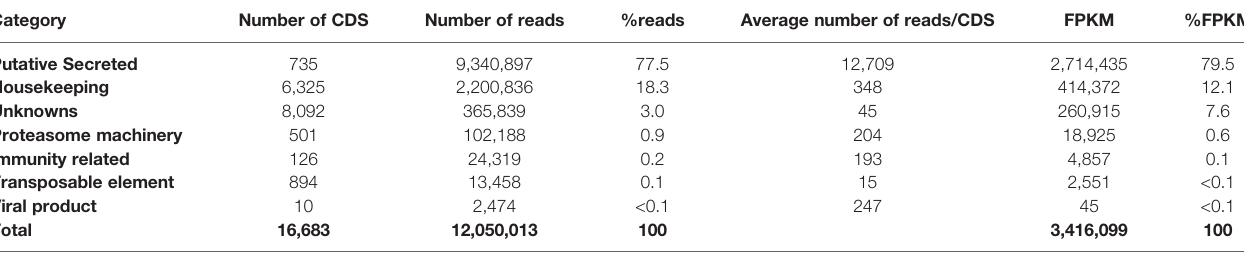
The values in bold correspond to the total for each class, group or